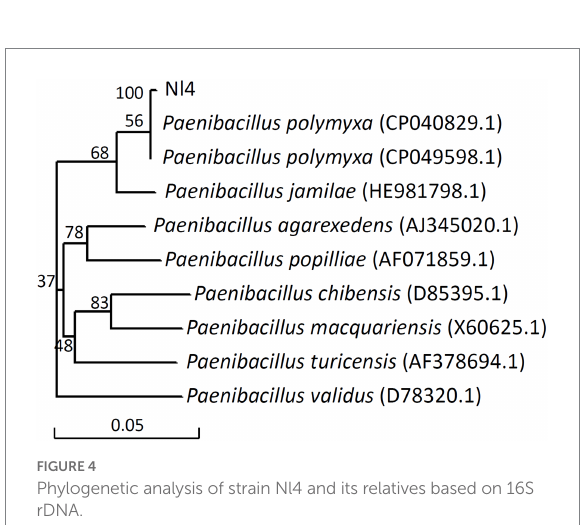
FIGURE 4 Phylogenetic analysis of strain Nl4 and its relatives based on 16S